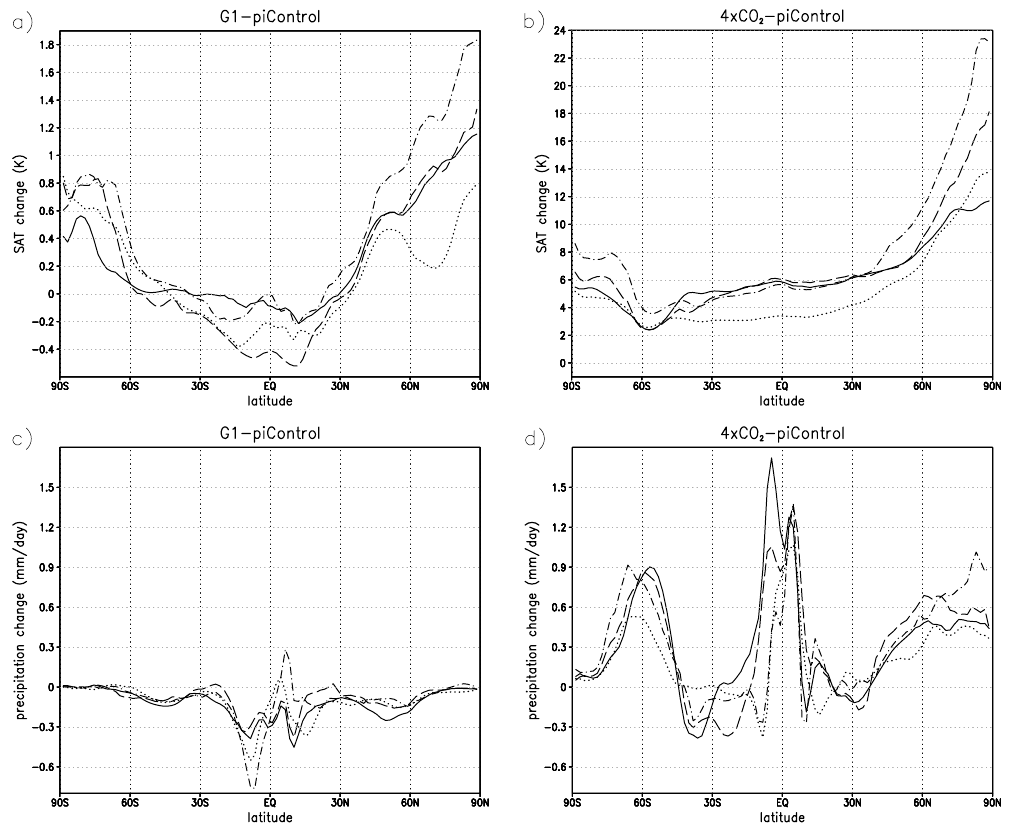
Fig. 4. Differences in zonally-averaged quantities between the simulations G1 and piControl (left panels), and abrupt4xco2 and piControl (right panels) from the four ESMs. Top panels: near surface air temperature (K), bottom panels: precipitation (mmday − 1 ). Solid: IPSL- CM5A, dashed: MPI-ESM, dotted: NorESM, dot-dashed: HadGEM2-ES. Note the different scaling of the temperature axes in the top